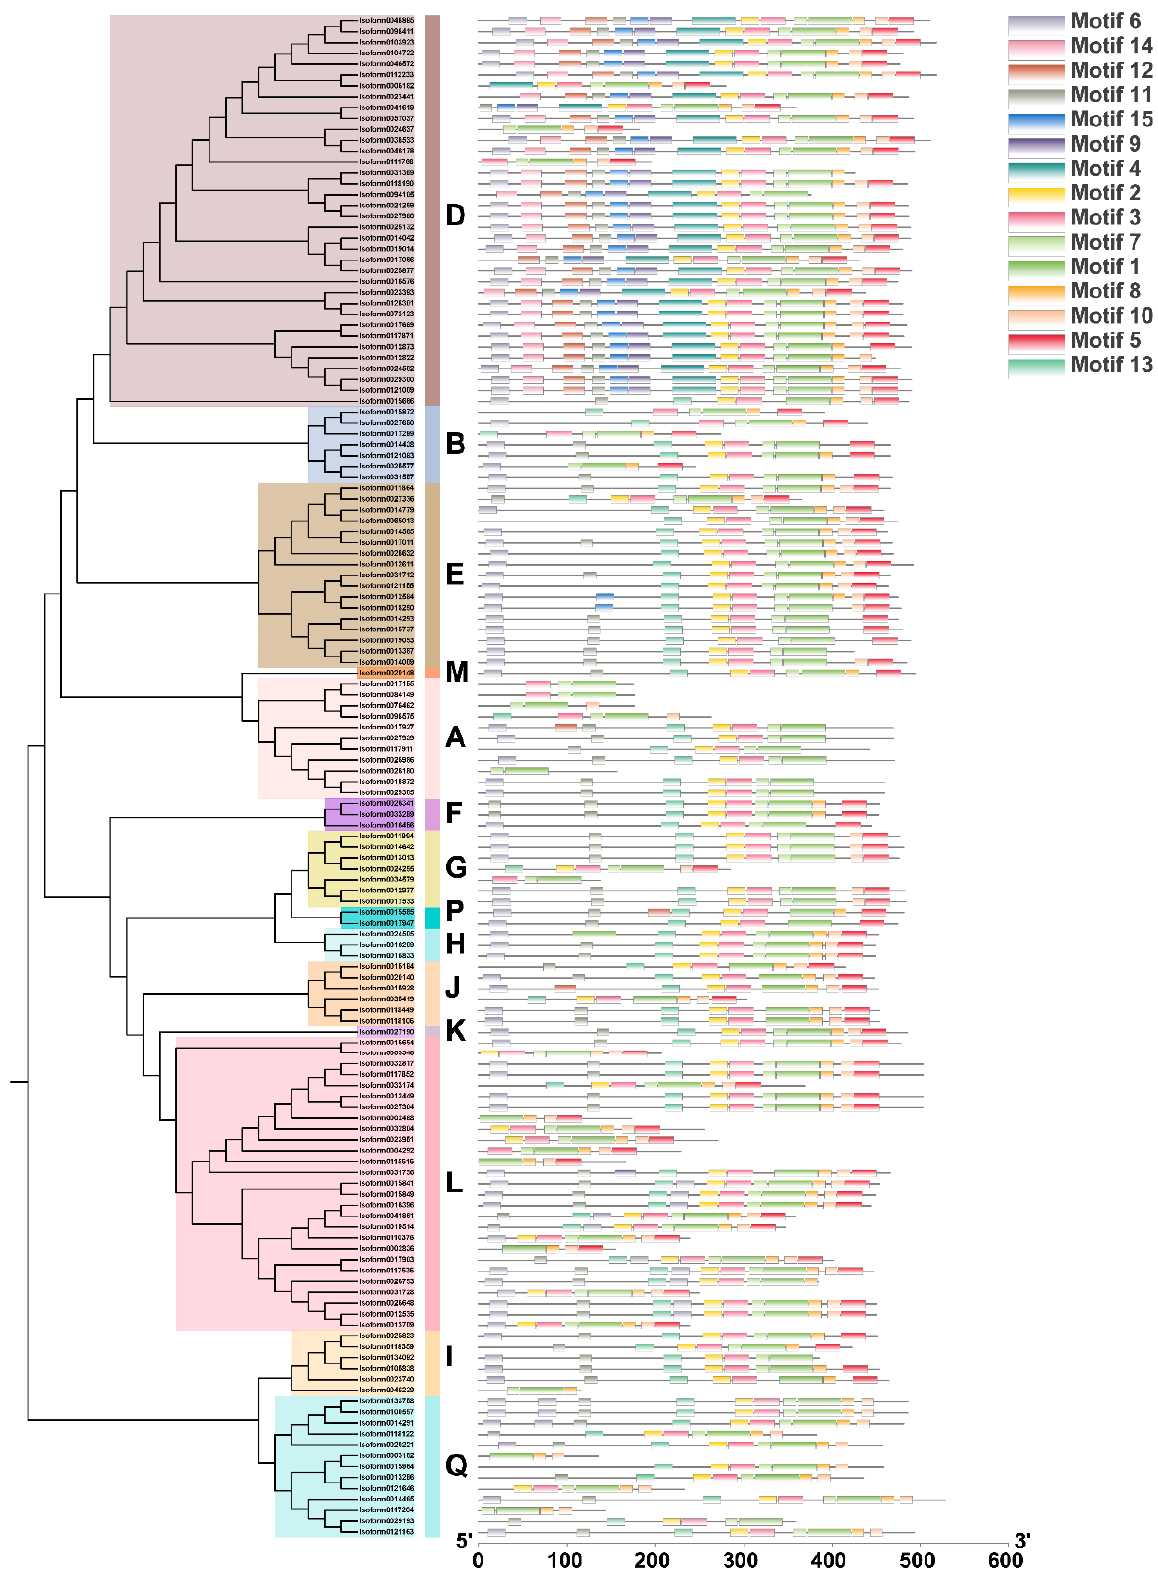
Figure 3. Distribution of conserved motifs of CaUGTs based on an evolutionary relationship. Phylogenetic tree and group classification of 140 CaUGTs on the left; 15 conserved motifs of CaUGT family members on the right. The sequence information for each motif is provided in Figure S2.